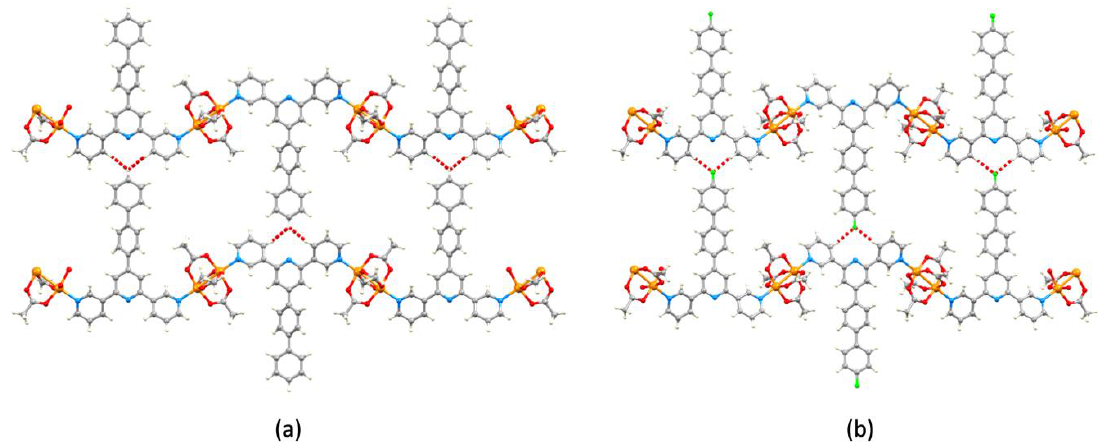
Figure 6. Packing of two adjacent polymer chains in ( a ) [Cu 2 ( µ -OAc) 4 ( 1 )] n and ( b ) [Cu 2 ( µ -OAc) 4 ( 2 )] within one 2D-sheet (see text). The hashed red lines highlight short H...H contacts in [Cu 2 ( µ -OAc) 4 ( 1 )] n and complementary short H...F contacts in [Cu 2 ( µ -OAc) 4 ( 2 )] n .